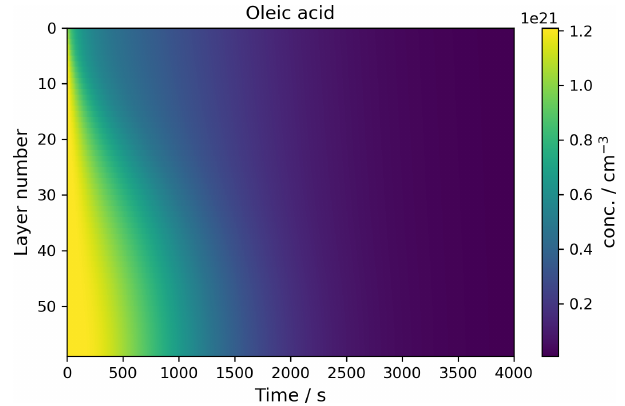
Figure 5. The concentration profile of a film of semi-solid (self- organised lamellar) oleic acid during ozonolysis. The film is 0.98µm thick, and 77ppm ozone was applied to the